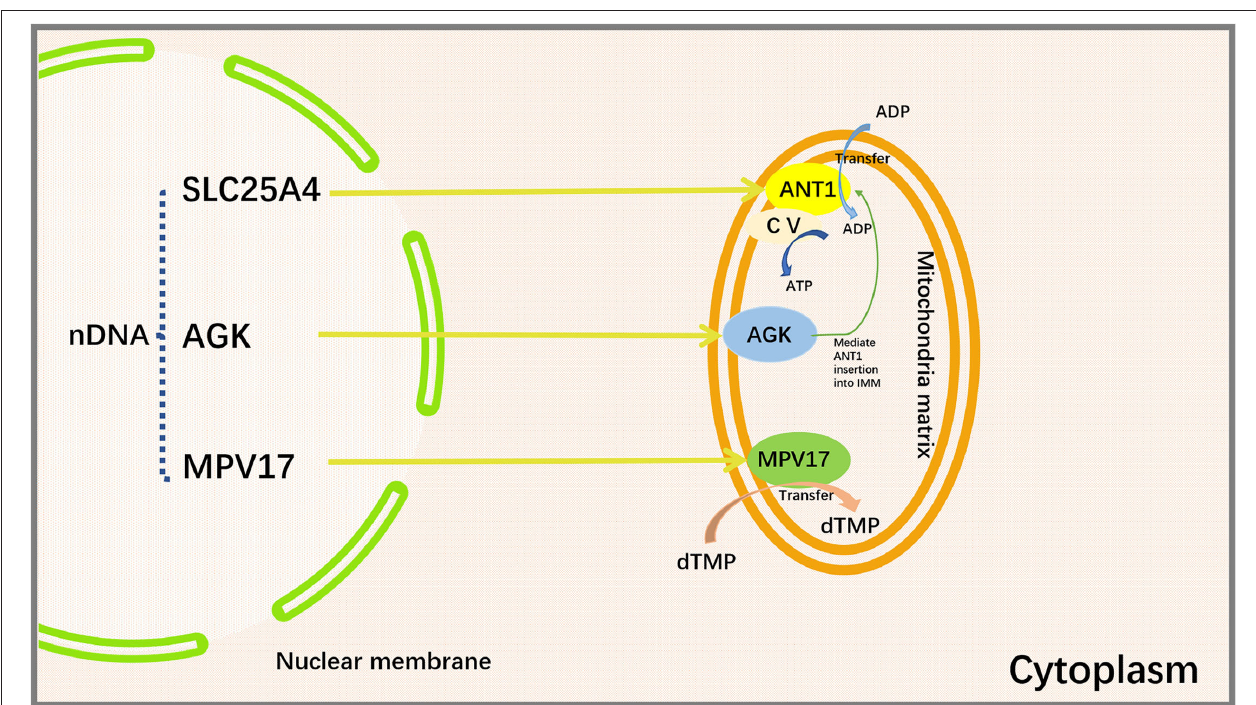
FIGURE 3 | Proteins encoded by SLC25A4 , AGK , and MPV17 genes and their functions. SLC25A4 , AGK and MPV are important mitochondrial transport proteins. Adenine nucleotide transporter (ANT1) is an ADP/ATP translocator encoded by SLC25A4 and located on the inner mitochondrial membrane. It mediates the transmembrane exchange of ADP and ATP and provides ADP for mitochondrial ATP synthase. Acylglycerol kinase is a mitochondrial lipid kinase encoded by AGK gene. The absence of AGK reduces the content of ANT1 in the inner membrane of muscle mitochondria by affecting lipid metabolism. MPV17 protein is encoded by MPV17 gene, which is involved in the maintenance of nucleotide homeostasis and transfers dTMP from the cytoplasm to the mitochondria to maintain mtDNA synthesis. SLC25A4 , Solute Carrier Family 25 Member 4; AGK , Acylglycerol Kinase; MPV17 , Mitochondrial Inner Membrane Protein MPV17 ; ANT1, Adenine nucleotide translocase 1; CV, Complex V, also known as ATP synthase, is one of the mitochondrial respiratory chain electron transport complexes; ADP, Adenosine diphosphate; ATP, Adenosine triphosphate; dTMP, deoxythymidine